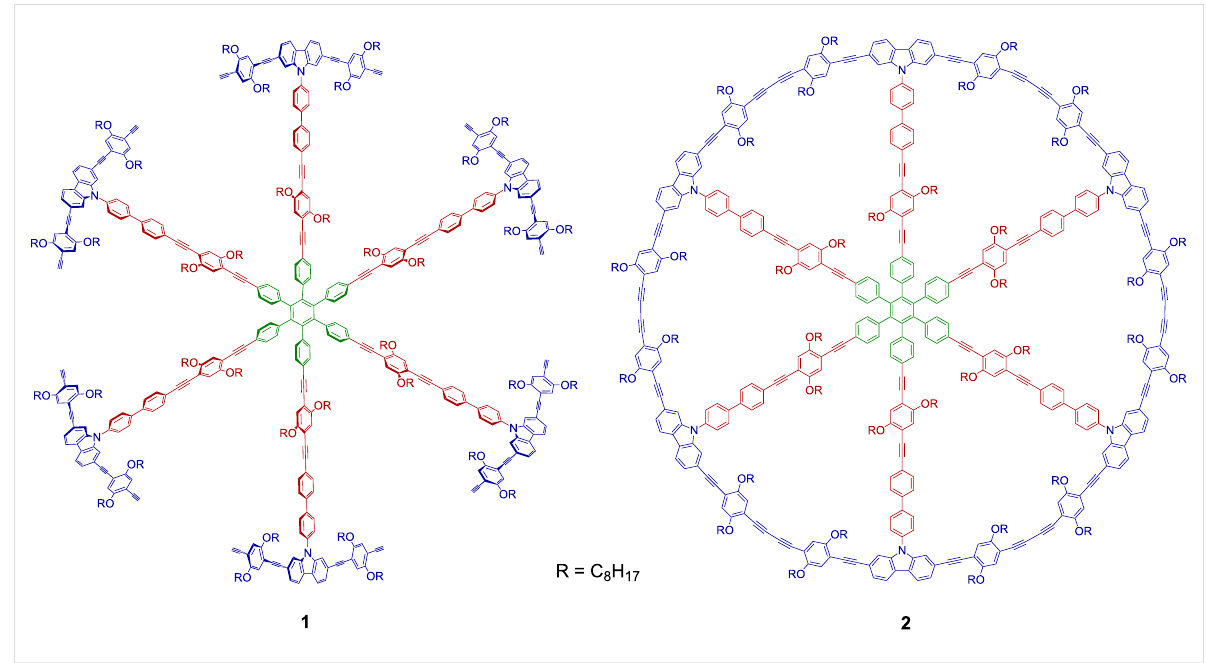
Figure 1: Chemical structures of precursor 1 and MSW 2 . Hub, spokes, and rim units are shown in green, red, and blue colors,